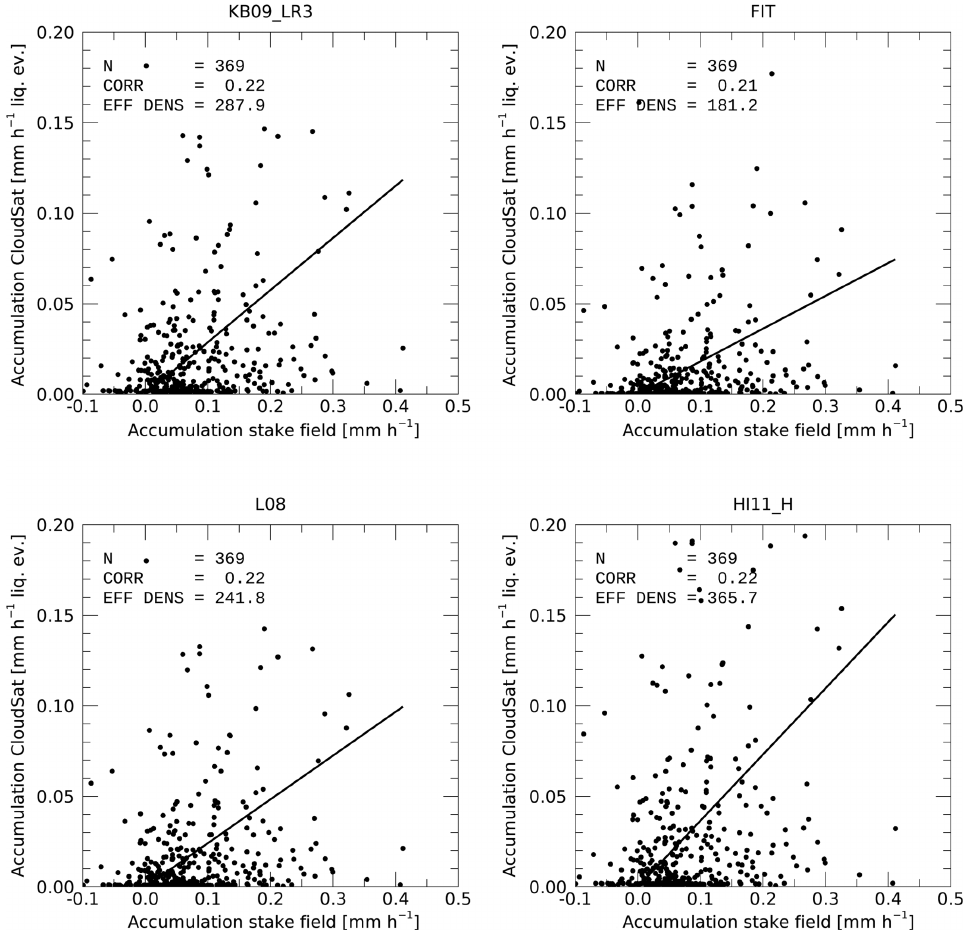
Figure 12. Same as Fig. 11 but for CloudSat versus stake field.